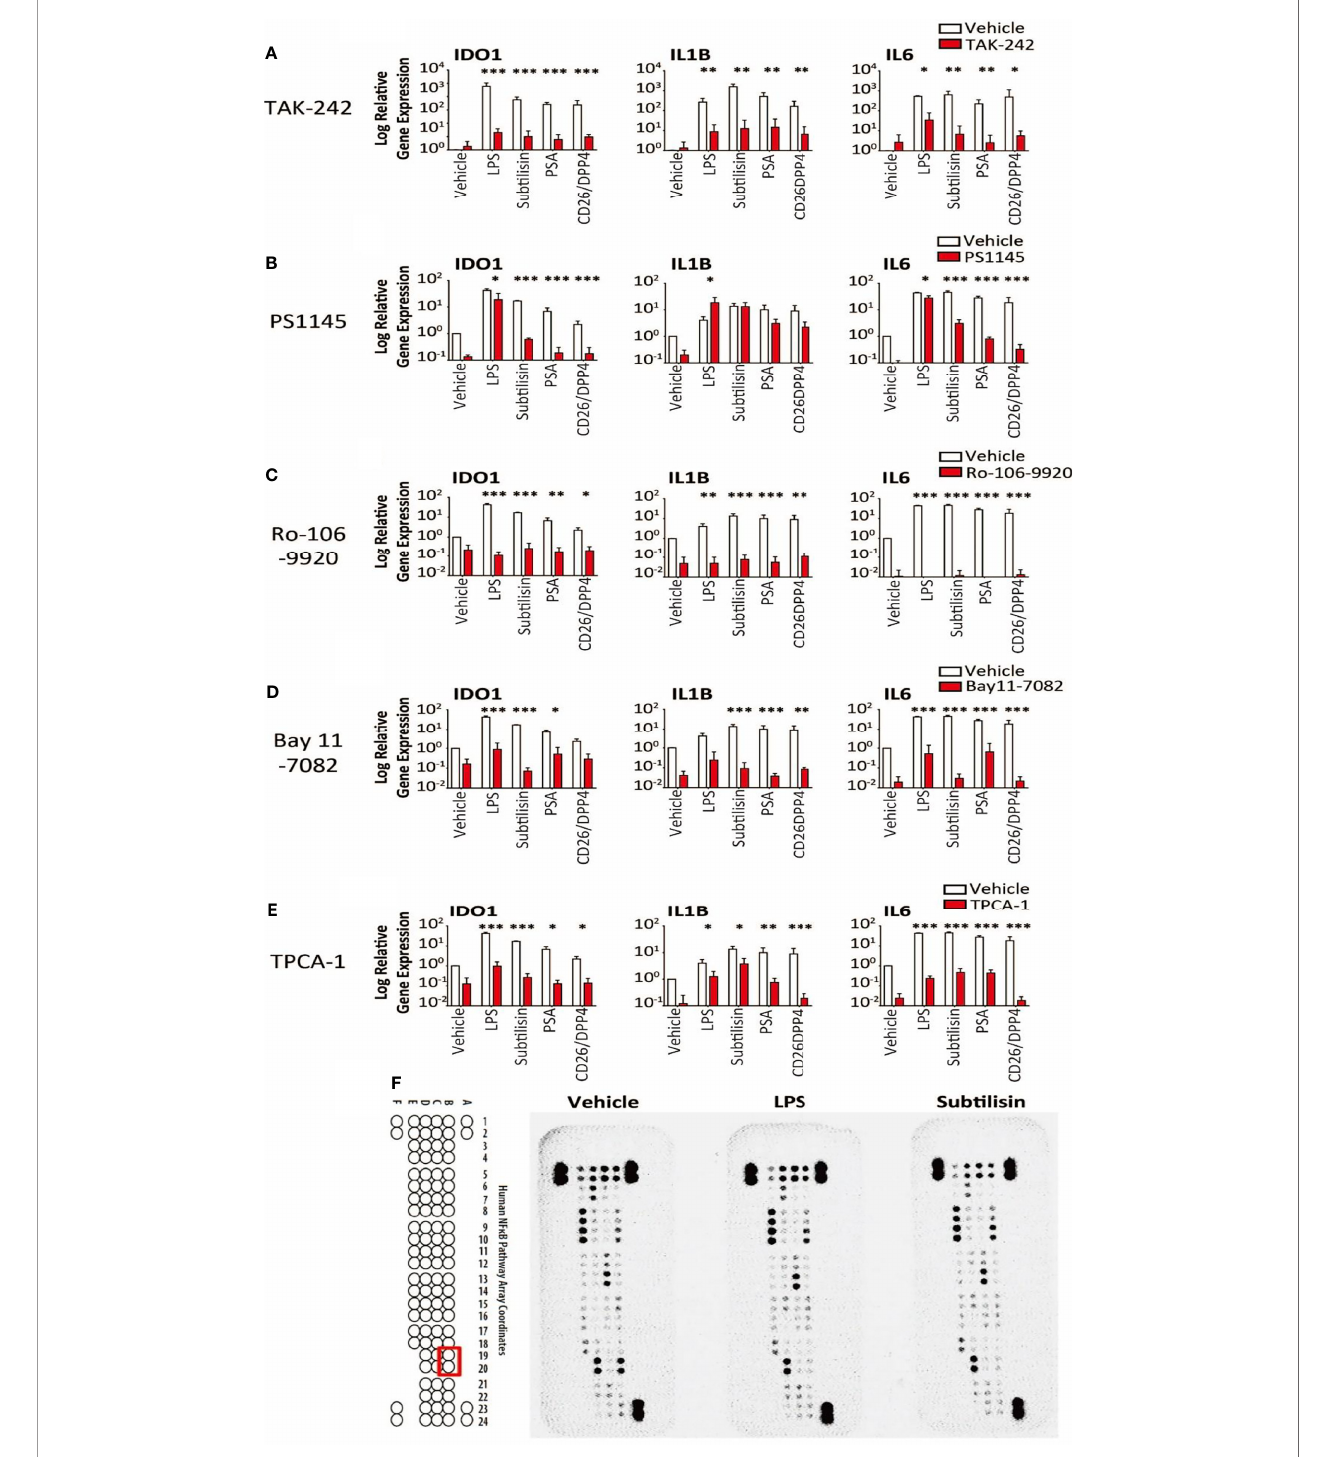
FIGURE 6 | Transduction pathways affected by serine proteases. The logarithmic relative expression of IDO1 , IL1B and IL6 induced by vehicle, LPS (10 ng/mL), subtilisin (20 nM), PSA (100 nM) and CD26/DPP4 (10 nM) in the presence of vehicle (open bars) or test agents (red/shaded bars): (A) TAK-242 (10 m M), (B) PS1145 (200 m M), (C) Ro-106-9920 (10 m M), (D) Bay11-7082 (10 m M) or (E) TPCA-1 (10 m M). Charts show the mean ± s.e.m. (n ≧ 3 donors). *P < 0.05, **P < 0.01; ***P < 0.001. (F) illustrates a proteomics array based on NF k B transduction pathways exposed to vehicle, LPS (10 ng/mL) or subtilisin (20 nM) for 0.5 h. LPS and subtilisin induced a loss of B19 and B20 corresponding to I k B e . Bars show the mean ± s.e.m. (n ≧ 3). *P < 0.05, **P < 0.01; ***P <